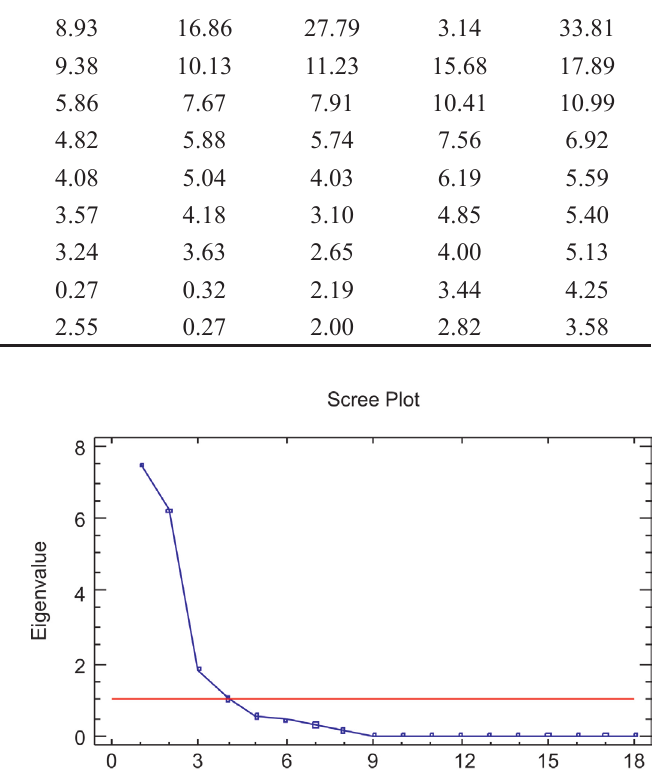
Solidity 0.88 Convex 0.93 DFC0 197.57 DFC1